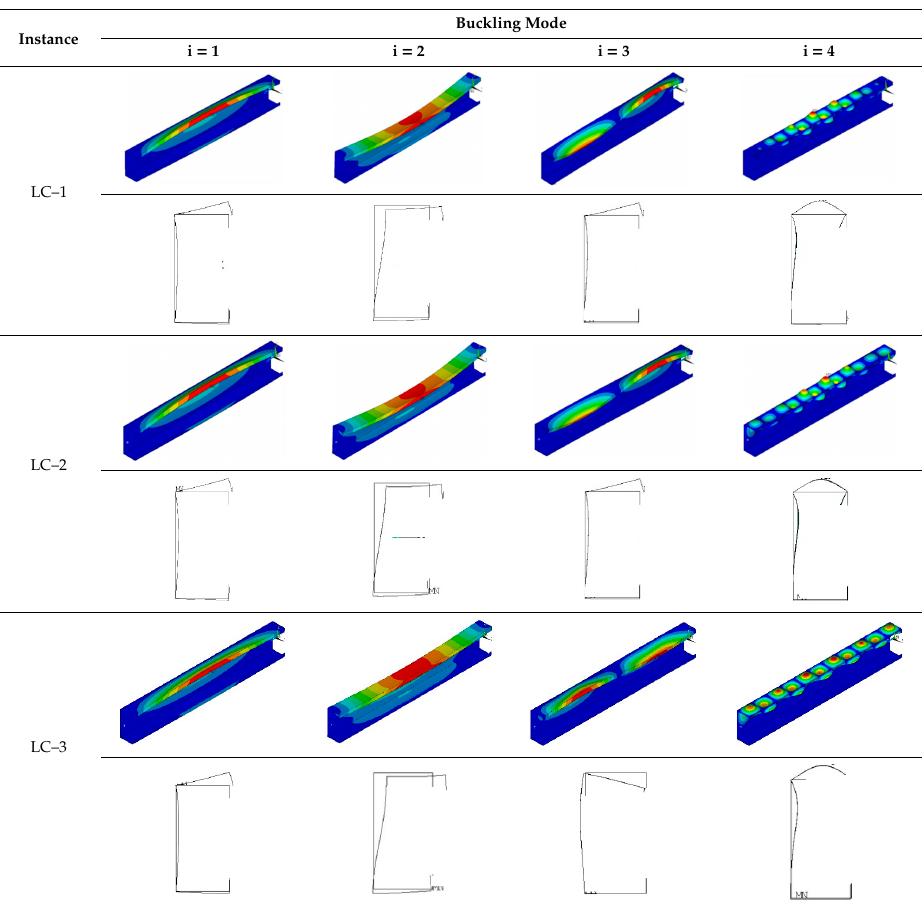
Table 6. Buckling modes of the considered FRP beams.